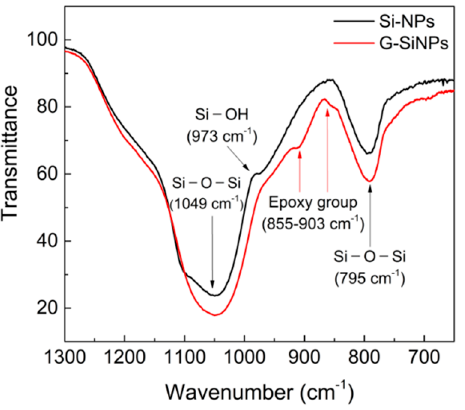
Figure 2. Fourier transform infrared (FT-IR) spectra of SiNPs (black) and G-SiNPs (red). The particle sizes of the Si-NPs and G-SiNPs were quantitatively compared using DLS. Although the diameters measured (25.266 and 35.367 nm for the Si-NPs and G-SiNPs, respectively) were slightly larger than those in the previous study considered (22.9